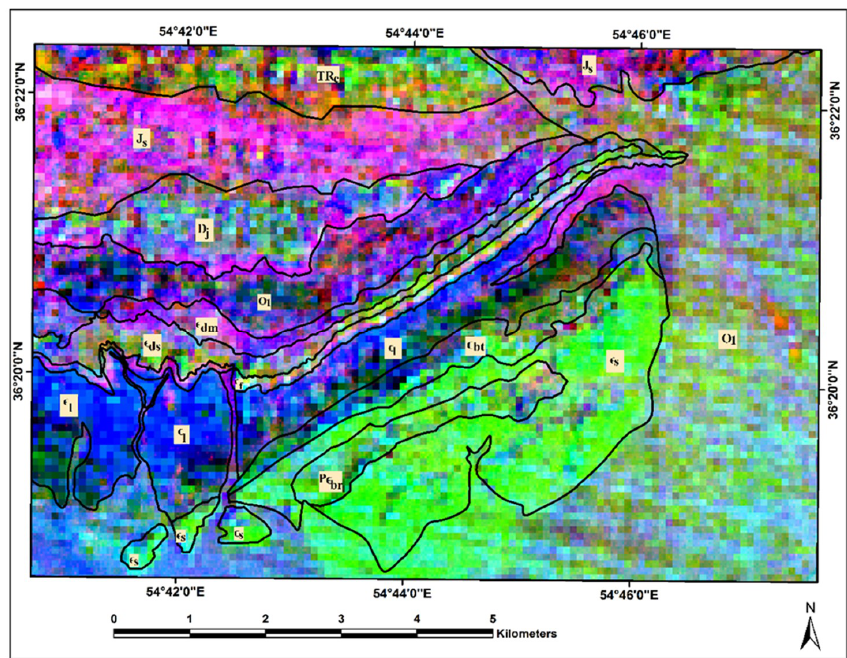
Figure 8. RGB Color composite of BRTM PC1, PC2, PC3 for the Deh-Molla region. Qal, Quaternary alluviums; Js, Shemshak Formation; TRe, Elika Formation; Dj, Jeirud Formation; Ol, Lashkarak Formation; Єdm, Deh-Molla Formation; Єds, De-Sufian Formation; Єf, Fasham; Єl, Lalun; Єz, Zagun Formation; Єbt, Barut Formation; Єs, Soltanieh Formation; PЄbr, Bayandor Formation.